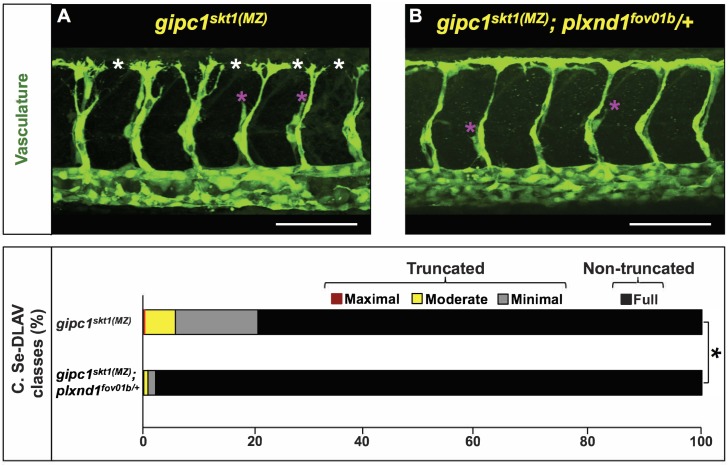
plxnd1 heterozygosity suppresses the angiogenesis deficits of gipc1skt1(MZ) mutants.(A, B) Confocal lateral images of the trunk vasculature (green) of 32 hpf embryos (region dorsal to the yolk extension). Anterior, left; dorsal, up. Scale bars (white horizontal lines), 100 μm. Genotypes indicated on top of each image in yellow font. Angiogenesis deficits are indicated with asterisks as follows: white (DLAV gaps), magenta (truncated Se). (C) Bar graph. Percentage of Se-DLAV in 32 hpf embryos of the indicated genotypes belonging to each of the following four phenotypic classes. Truncated: maximal (red; includes missing Se), moderate (yellow), and minimal (gray). Non-truncated: full (black). There was a statistically significant difference (bracket with an asterisk) in distribution of the four phenotypic classes between gipc1skt1(MZ) and gipc1skt1(MZ); plxnd1fov01b/+ embryos, as assessed by a two-sided Fisher Exact test (p<0.05). Quantifications. We scored Se-DLAV angiogenesis in embryos of the following two genotypes: gipc1skt1(MZ) (390 Se-DLAV, 36 embryos, an average of 10.83 Se-DLAV/embryo) and gipc1skt1(MZ); plxnd1fov01b/+ (410 Se-DLAV, 38 embryos, an average of 10.79 Se-DLAV/embryo). For additional data, graphs, and statistical comparisons related to this figure, see Figure 5—figure supplement 1 and Supplementary file 6. Please note that given the use of different scales for scoring angiogenesis deficits, it is unfeasible to compare the quantifications in Figure 4 and Figure 5 directly.